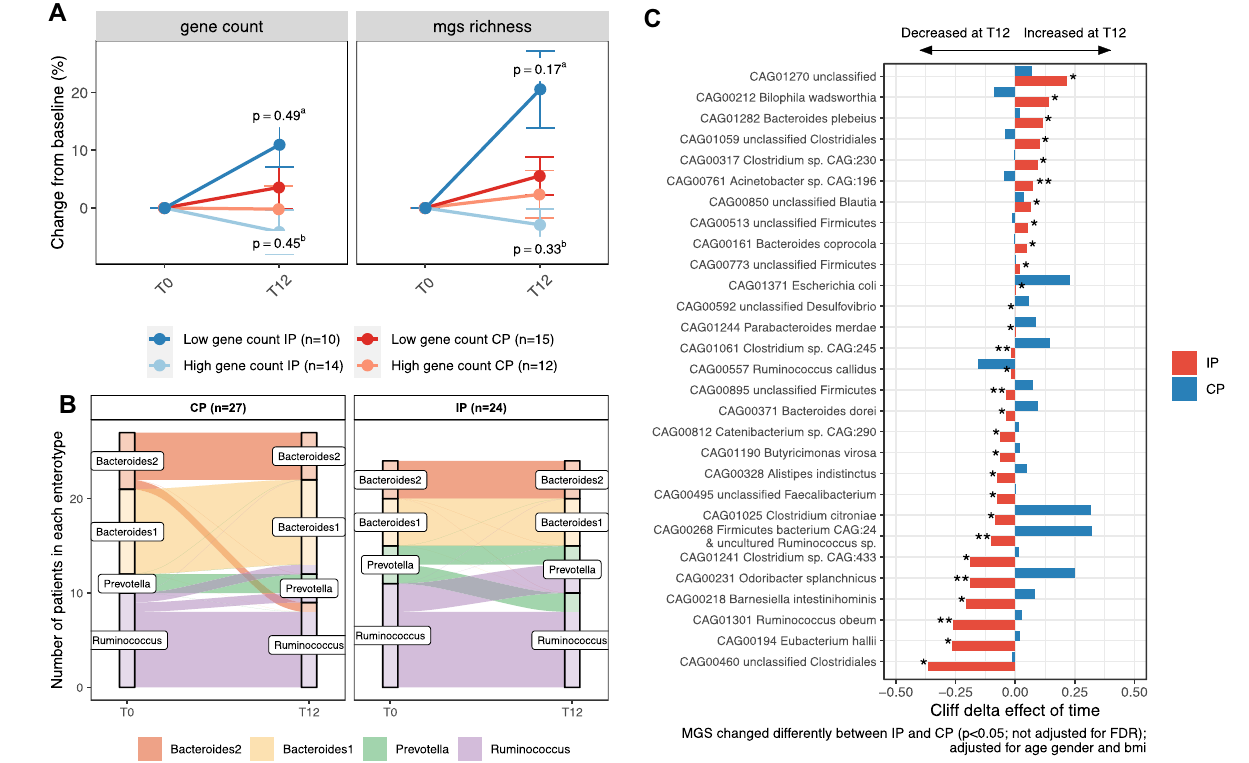
Figure 3. Effects of protein supplementation on gut microbiome composition (IP vs. CP). ( A ) Evolution (relative change at T12) of gene count and MGS richness (number of present species) in investigational product group (IP, red colours) and Comparator group (CP, blue colours) depending on baseline metagenomic richness. LGC: low gene count at baseline (light colours). HGC: high gene count at baseline. p value of the effect intervention interaction with time in LGC patients (a) and HGC patients (b); ( B ) Alluvial plot showing the evolution of enterotype between T0 and T12 in CP group (left panel) and IP group (right panel); ( C ) Untargeted analysis of the effects of IP on metagenomic species (MGS) abundance changes with the intervention. MGS shown are the ones with a significant interaction of time with intervention in a mixed linear model with patients as random effects adjusted for baseline age, sex and BMI ( p < 0.05 without adjustment for multiple comparisons). Bars represent the cliff delta effect of time (T12 vs T0) on MGS abundance in each group. * p < 0.05; ** p < 0.01; *** p < 0.001 No significant differences resist to adjustment for multiple comparisons. IP: investigational product (high protein); CP: comparator product. Figure conceived using R version 3.3.2, R Core Team (2019), https:// www.R- proje ct.